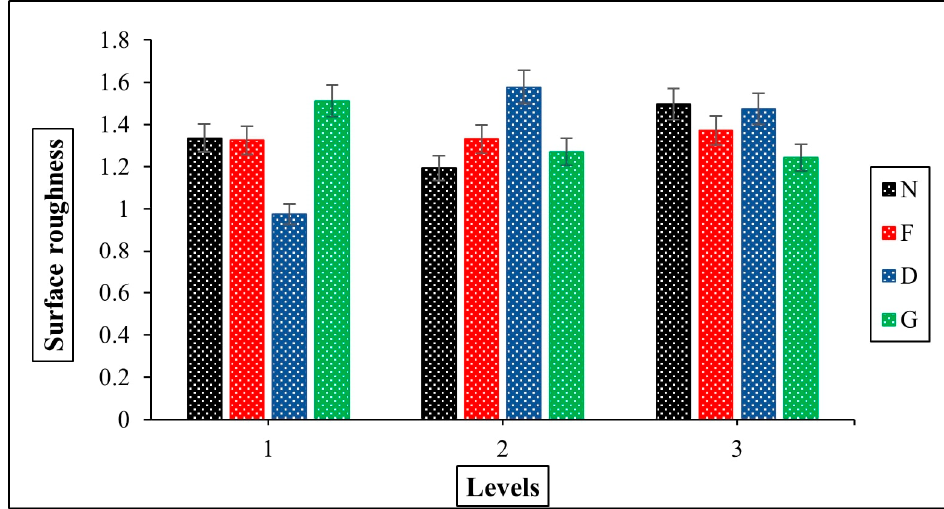
Figure 5. Surface roughness vs. milling factors analysis.